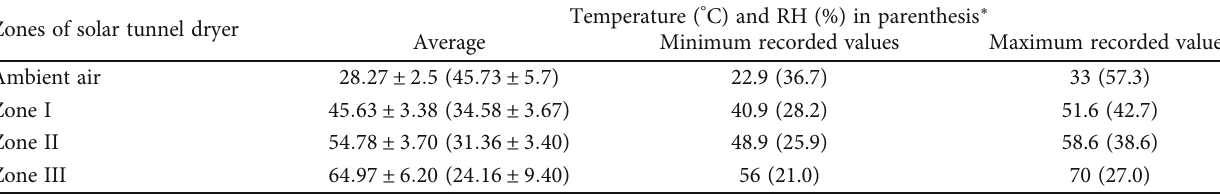
Table 1: Average, maximum and minimum temperature and relative humidity at three zones and ambient air recorded during drying time. Zones of solar tunnel